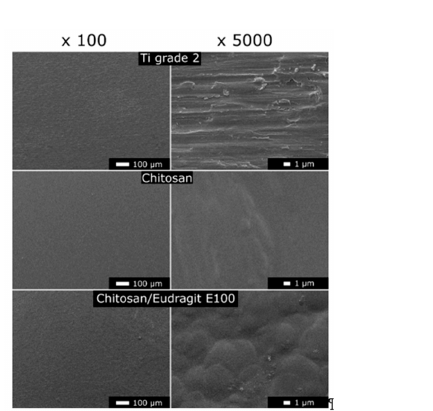
Table 5. Open circuit potential, corrosion potential, and current density of the Ti grade 2 substrate and coated substrate with chitosan and chit / EE100 (sample A1).